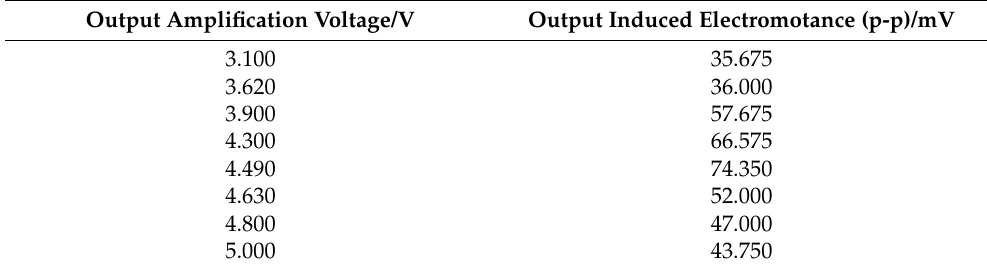
Table 2. Detection results under different original output amplification voltages of detection